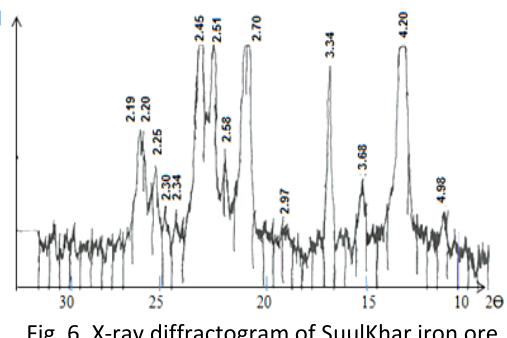
Fig. 3. DTA/TG curves of the SuulKhar iron ore.